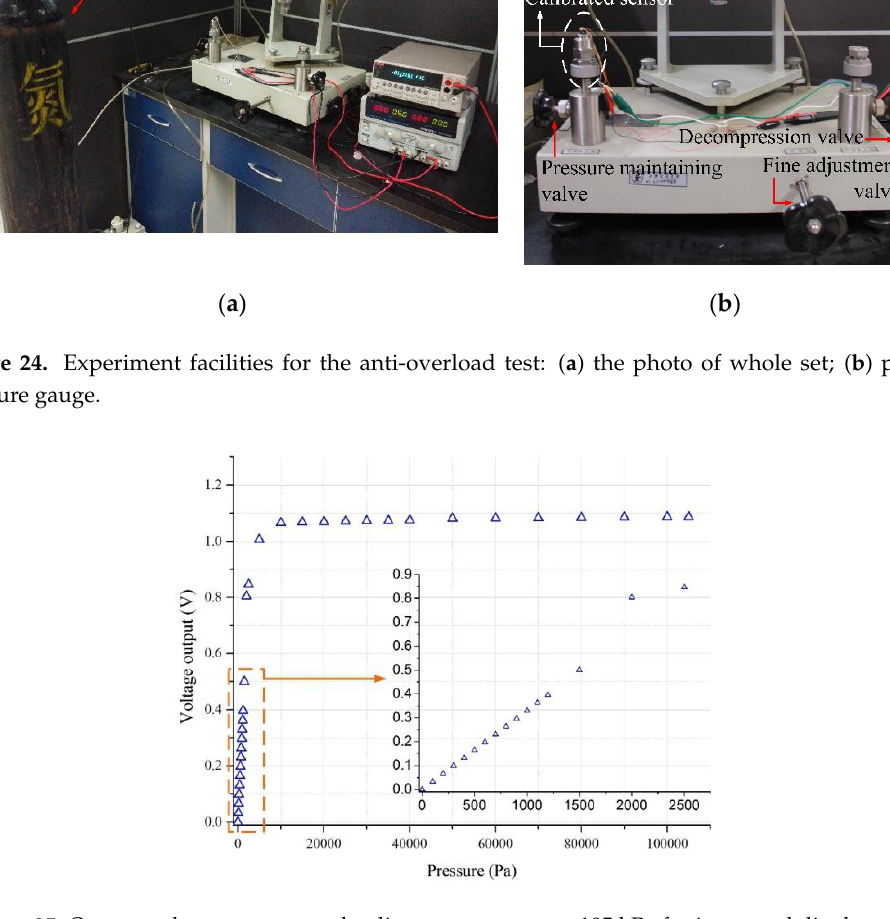
Figure 25. Output voltage versus overloading pressures up to 105 kPa for improved diaphragm I.